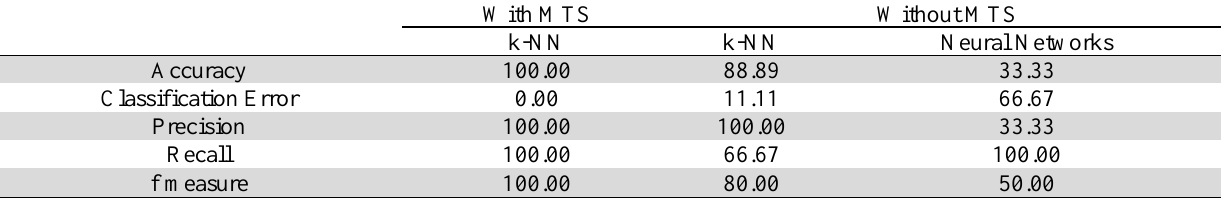
Comparison of MTS methodology with other techniques